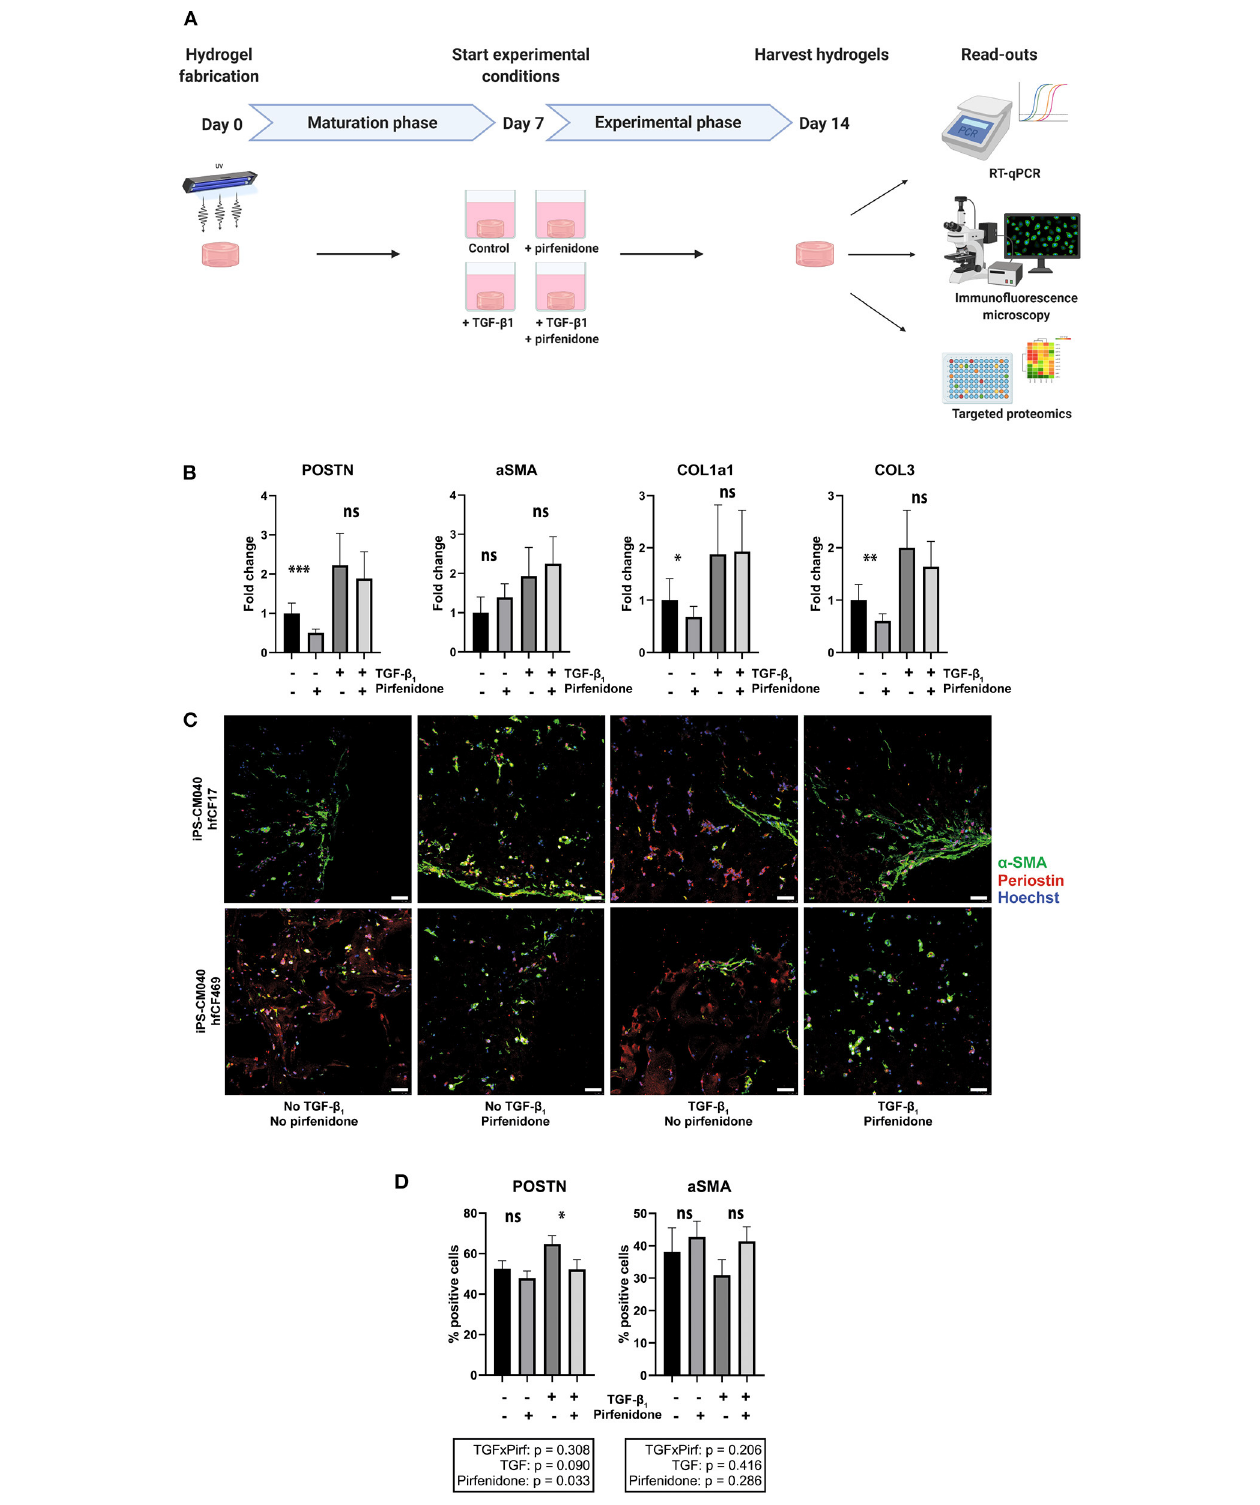
FIGURE 4 | Pirfenidone has distinct anti-fibrotic effects in cardiac tissue constructs. (A) Timeline of the experiment. Cardiac tissue constructs were fabricated at day 0 and cultured under regular circumstances until day 7. On day 7, experimental conditions were started. Four experimental conditions were created, in which TGF- β 1